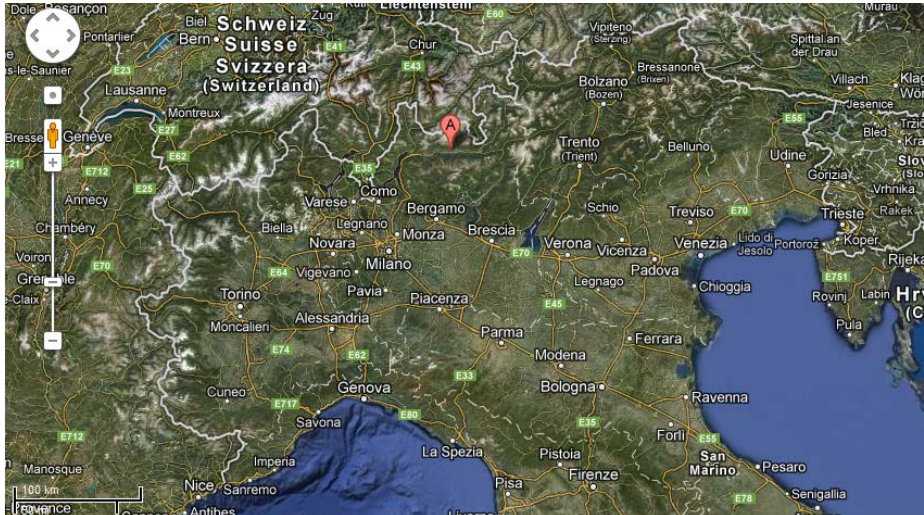
Figure 3. Map of Northern Italy. Sondrio is identified by the red marker A. 2 Fig. 3. Map of northern Italy. Sondrio is identified by the red marker A.